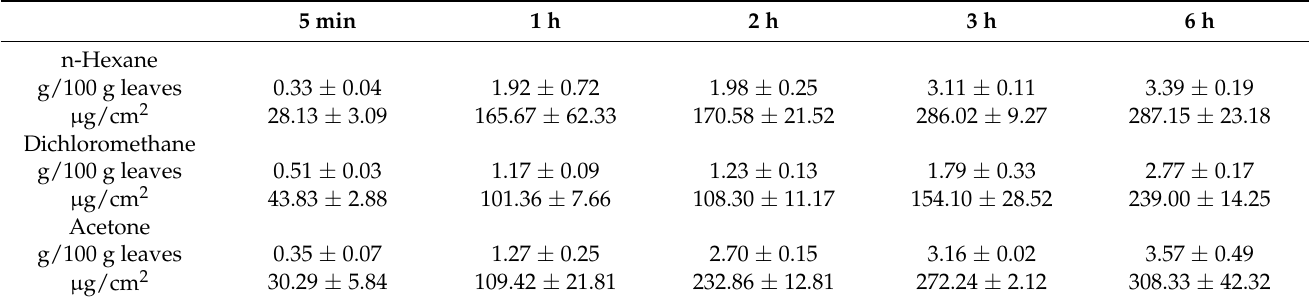
Table 1. Yields of material solubilized from the surface of whole Q. suber leaves by different solvents and extraction times, in g per 100 g dry leaves, and µ g per cm 2 of leaf